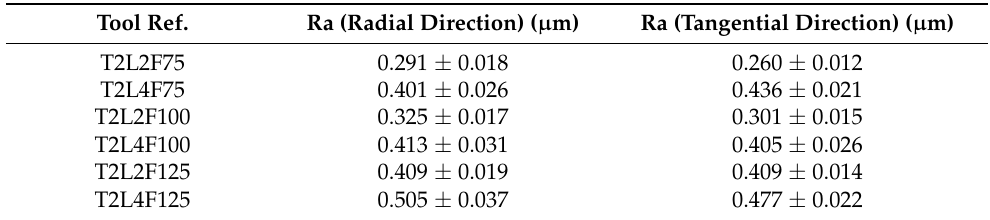
Table 9. Average surface roughness values, measured in the radial and tangential directions for the tests conducted with